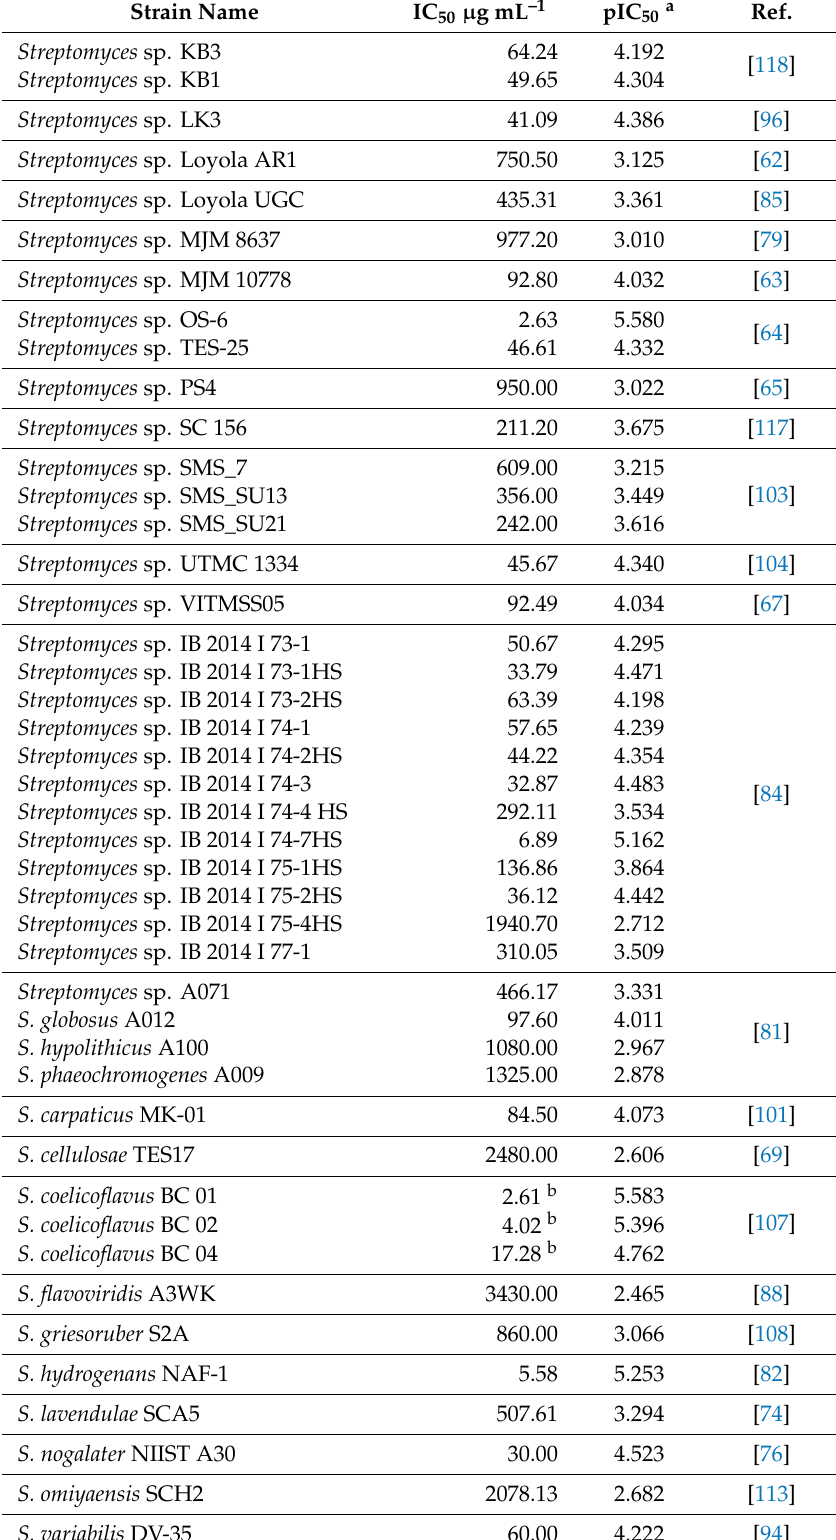
Table 2. Antioxidant capacity of crude extracts from Streptomyces